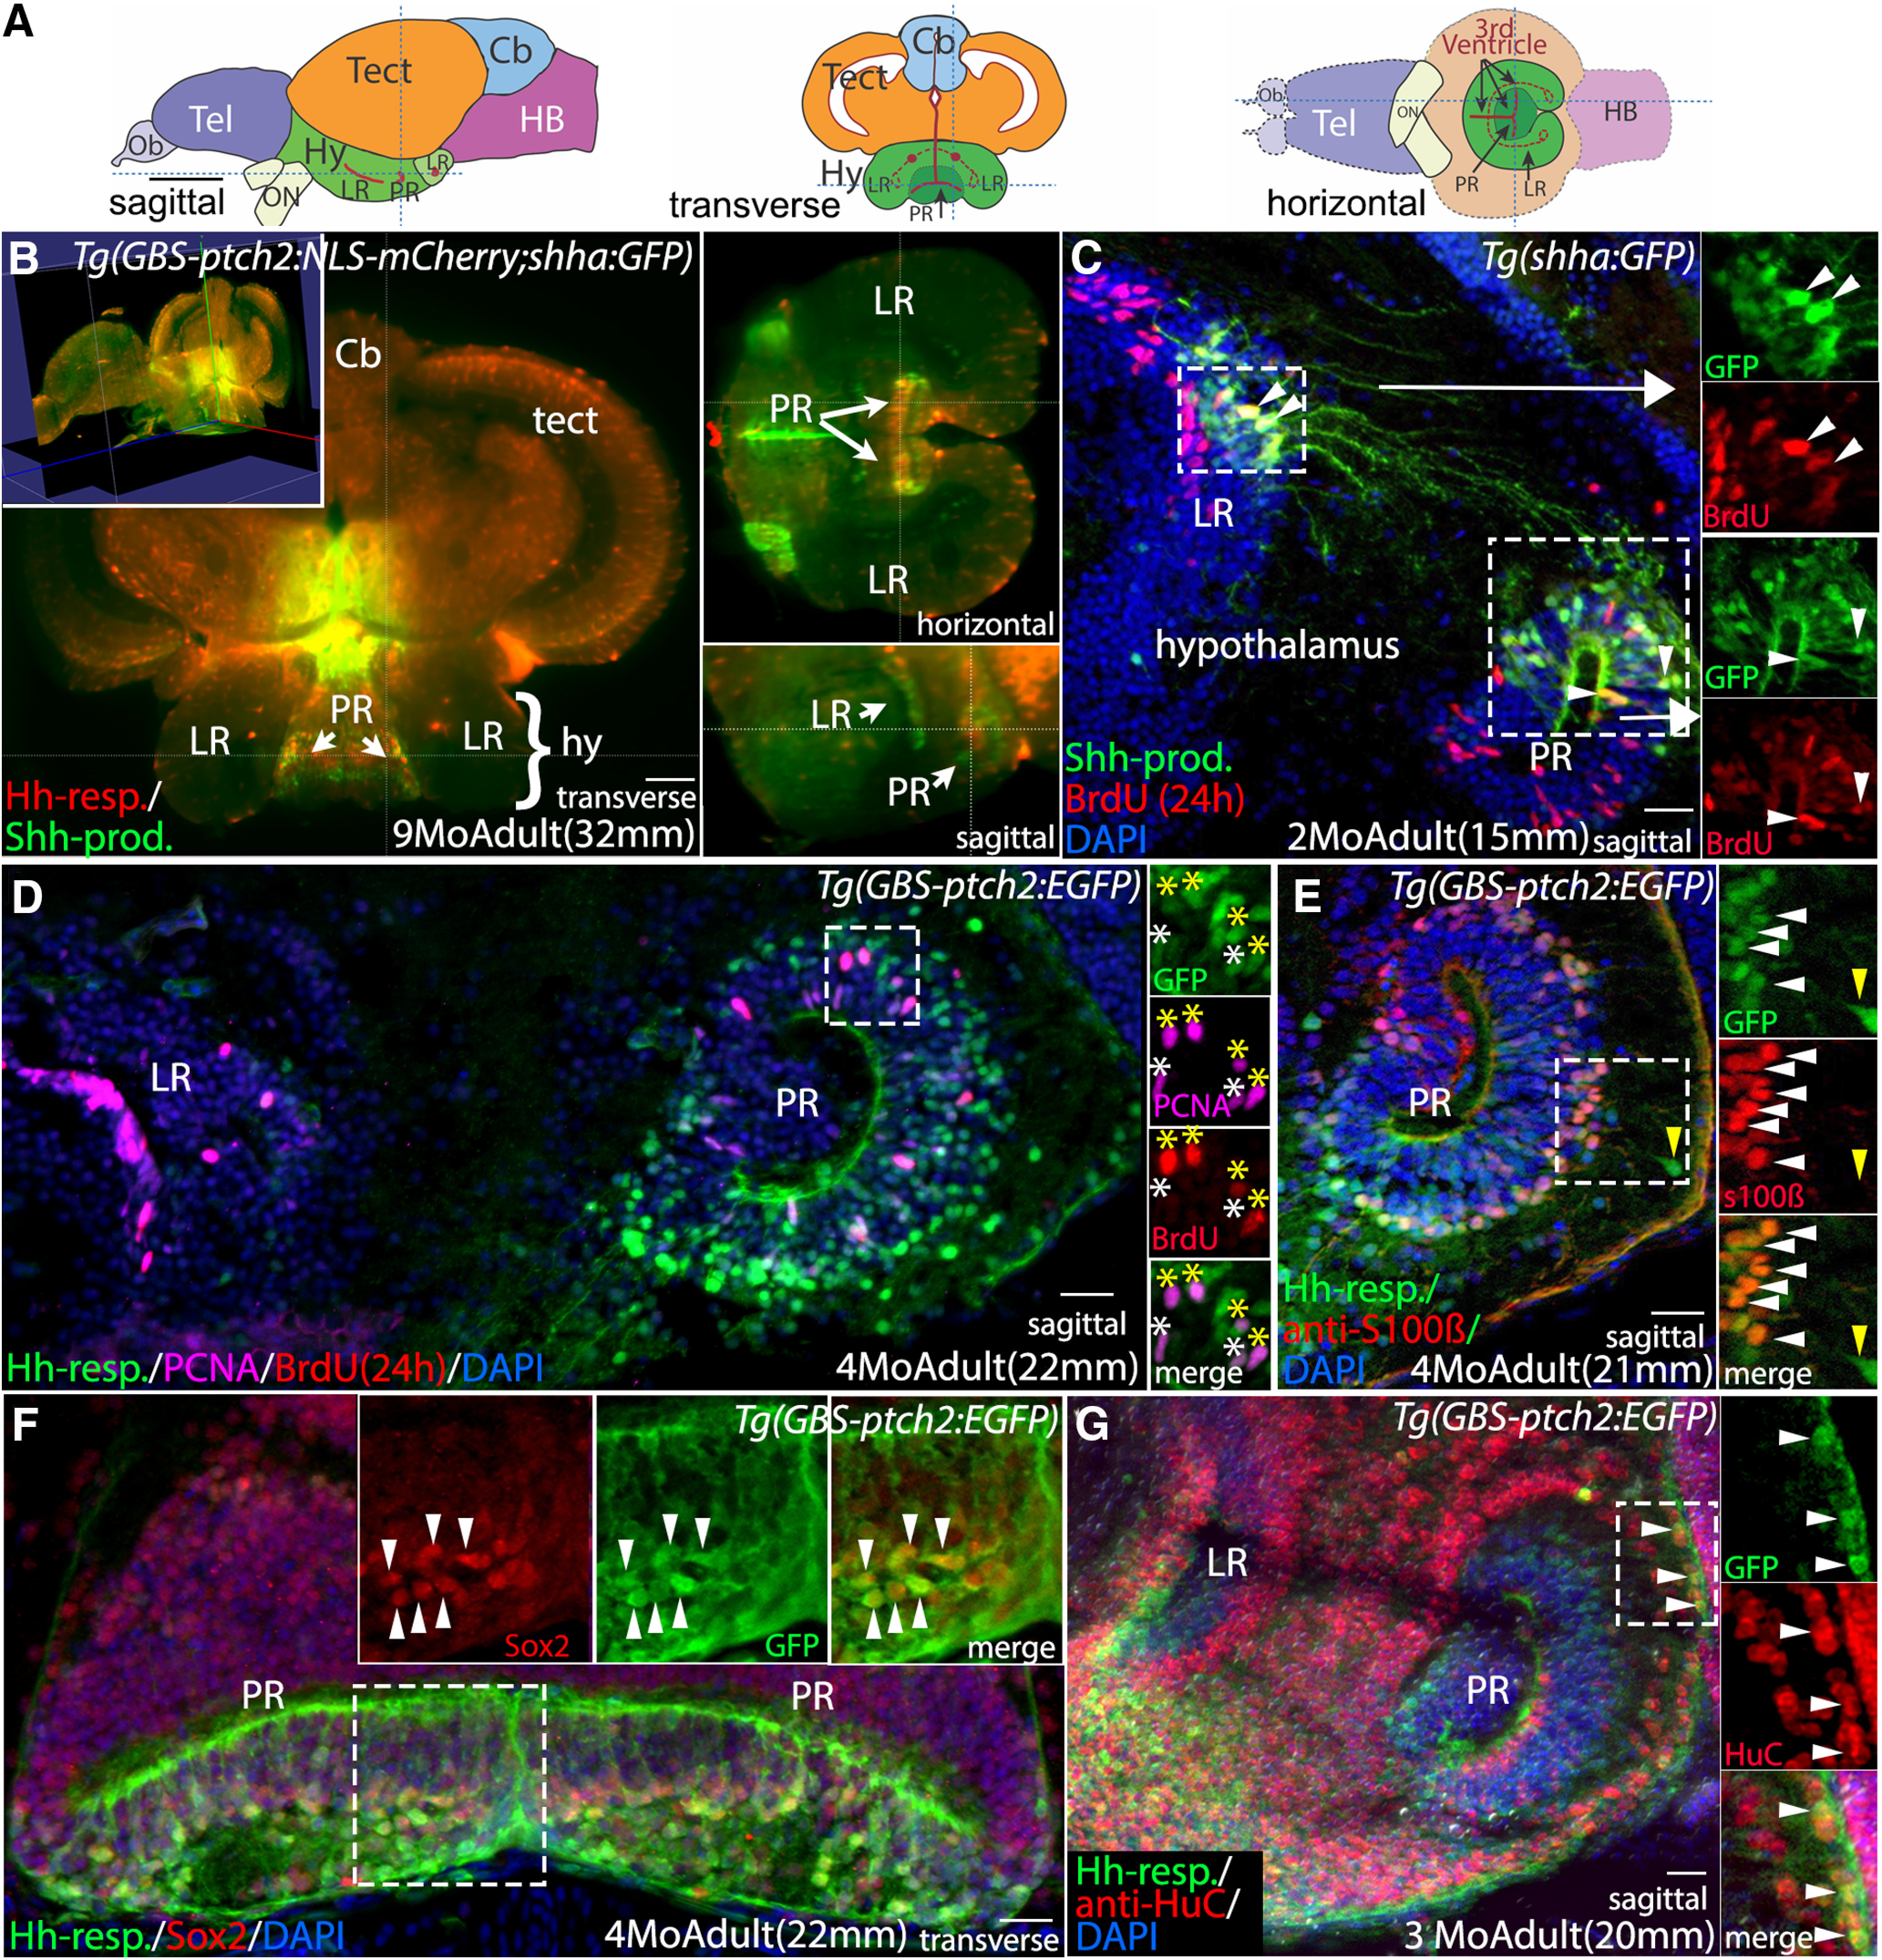
 Shh-producing and Hh-responsive radial glial cells in the adult hypothalamus are proliferative neural precursors. A, Schematic sagittal, transverse, and horizontal sections through the adult zebrafish brain. B, Optical sections from a whole-brain light-sheet confocal image of a Tg(GBS-ptch2:NLS-mCherry;shha:GFP) double transgenic adult showing Hh-responsive cells (Hh-resp, red) in relation to Shh-producing cells (Shh-Prod, green) in the LR and PR of the adult hypothalamic (third) ventricle. Shh-expressing cells are adjacent to Hh-responsive cells in the ventricular zone of both recesses. Yellow lines in each panel indicate the plane of section in the other panels. Video 1 shows a progression through optical sections (from posterior to anterior), and Video 2 shows a 3-dimensional rotating view of this image. C, Sagittal tissue section showing Shh-producing cells (green) and BrdU-labeled proliferative cells (red, 24-h exposure) in the adult hypothalamus. Shh-producing cells are located primarily in the dorsal portions of both the LR and PR. Shh-expressing cells in the LR send projections toward to the dorsal region of the PR. Panels at right show separated fluorescent channels from the boxed regions, with examples of co-labeled cells in both ventricular regions indicated by arrowheads. D, Sagittal tissue section through the LR and PR of a Tg(GBS-ptch2:EGFP) transgenic adult showing Hh-responsive cells and proliferative cells labeled with BrdU (red, 24-h treatment) and the anti-PCNA antibody (magenta). Panels at right show separated channels from the boxed region, with four PCNA+/BrdU+-labeled Hh-responsive cells indicated by yellow asterisks and two PCNA+/BrdU– cells indicated by white asterisks. E, Sagittal tissue section through the PR of a Tg(GBS-ptch2:EGFP) transgenic adult labeled with the anti-s100β antibody to show radial glia. Most but not all Hh-responsive cells are s100β-positive (white arrowheads). A small percentage of GFP-labeled cells that are more distant from the ventricle are s100β-negative (yellow arrowhead), suggesting these cells have differentiated but retain GFP fluorescence from previous GBS-ptch2:EGFP transgene expression. F, Transverse tissue section through the PR of the hypothalamus of a Tg(GBS-ptch2:EGFP) adult labeled with the Sox2 antibody that labels neurogenic cells. Most or all Hh-responsive cells express the Sox2 protein. Panels at right show separated channels from the boxed region with arrowheads marking co-labeled cells. G, Sagittal tissue section through the PR of a Tg(GBS-ptch2:EGFP) adult labeled with an antibody to the neuronal marker HuC/D (now called Elavl3). Double labeling of cells far from the ventricle indicates that Hh-responsive cells (green) can give rise to HuC/D-expressing neurons (red). Panels at right show separated channels from the boxed region with co-labeled cells (arrowheads). Cb, cerebellum; hy, hypothalamus; LR, lateral recess of the hypothalamic (third) ventricle; PR, posterior recess of the hypothalamic (third) ventricle; tect, tectum. Scale bars: 1 mm (A), 50 μm (B), and 20 μm (C–H).